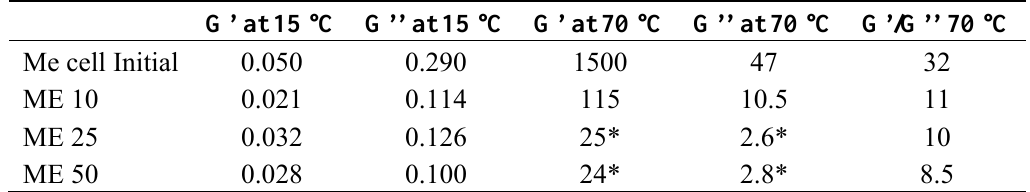
* apparent values due to heterogeneity of the